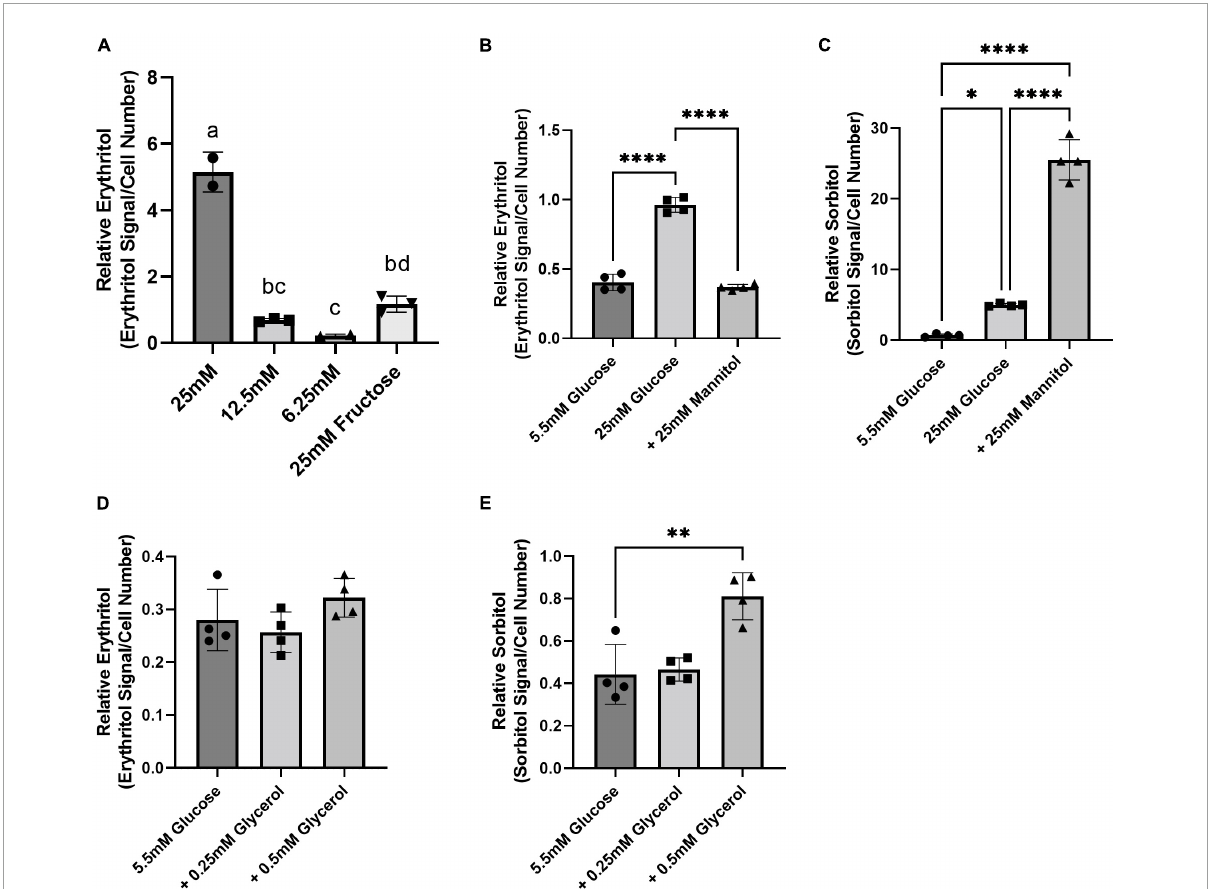
FIGURE1 Intracellular erythritol and sorbitol levels respond to carbohydrate concentrations in media and osmotic stress. (A) Relative erythritol in cells cultured for 48 h in media containing 25, 12.5, or 6.25 mM glucose or 25 mM fructose. Labeled means without a common letter differ, p < 0.05. (B) Relative erythritol and (C) relative sorbitol in cells cultured in media containing 5.5 or 25 mM glucose, or 5.5 mM glucose supplemented with 25 mM mannitol. (D) Relative erythritol and (E) relative sorbitol in cells cultured in 5.5 mM glucose media or 5.5 mM glucose media containing 0.25 or 0.5 mM glycerol. All relative metabolite values are normalized to internal standard and cell number. Data are shown as mean ± SD and were analyzed by one-way ANOVA, followed by Tukey’s multiple comparisons test ( n = 2–4). ∗ p < 0.05, ∗∗ p < 0.01, ∗∗∗∗ p <